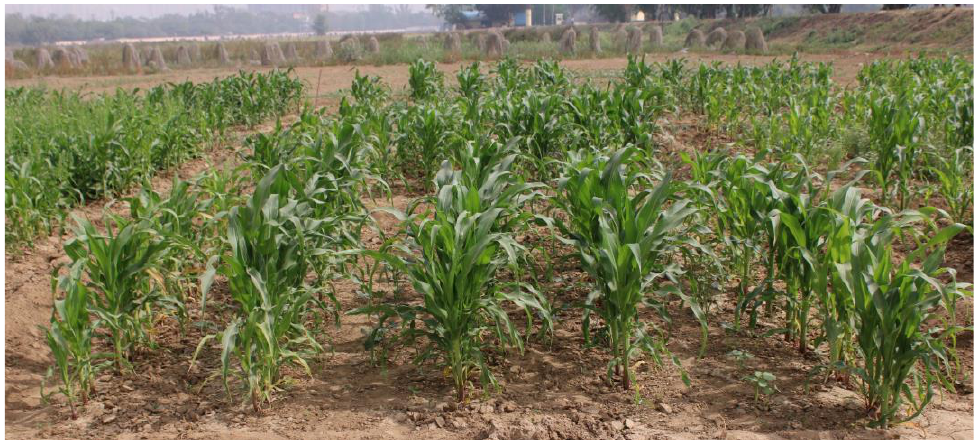
Figure 7. Maize + Lady’s finger, Abelmoschus esculentus intercropping system.